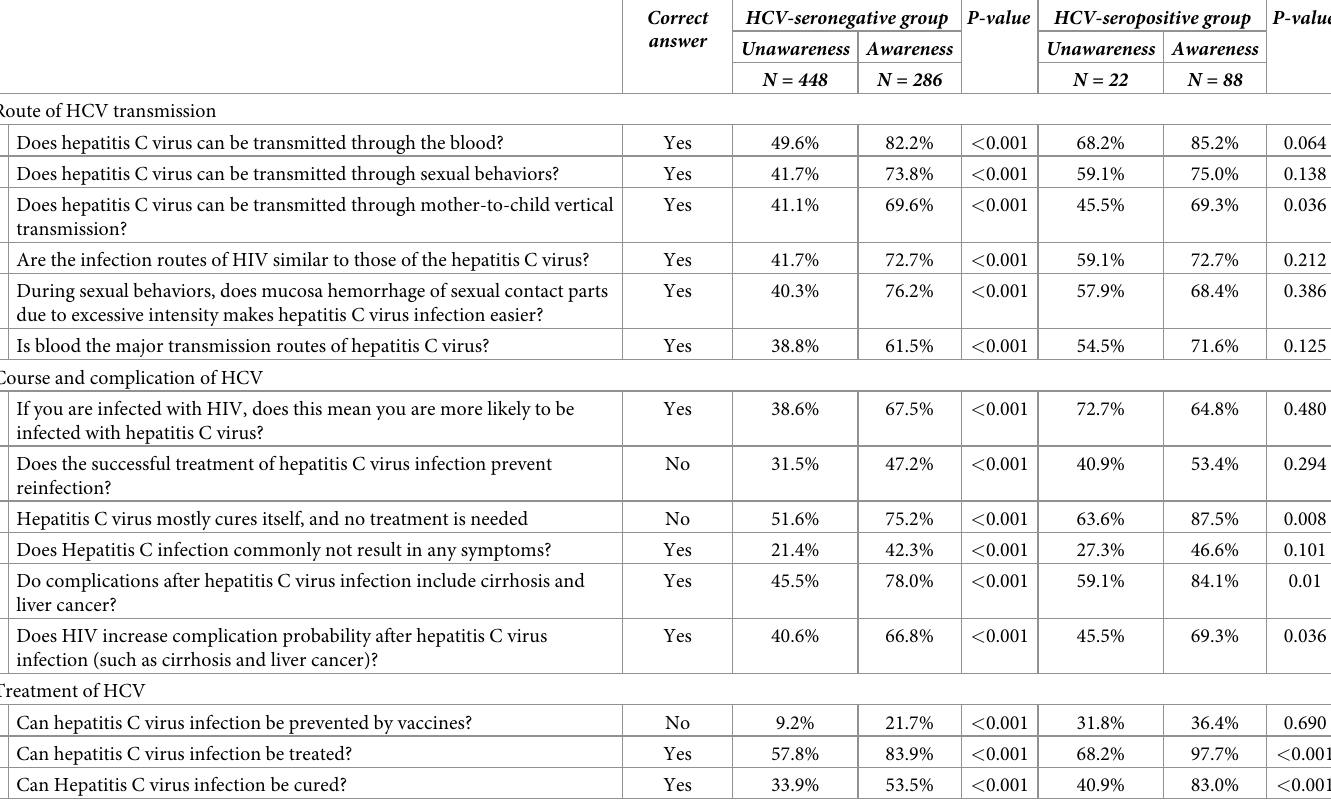
Table 3. Comparison of correct responses to structural questions on HCV knowledge between participants with and without awareness of their HCV status, strati- fied by HCV